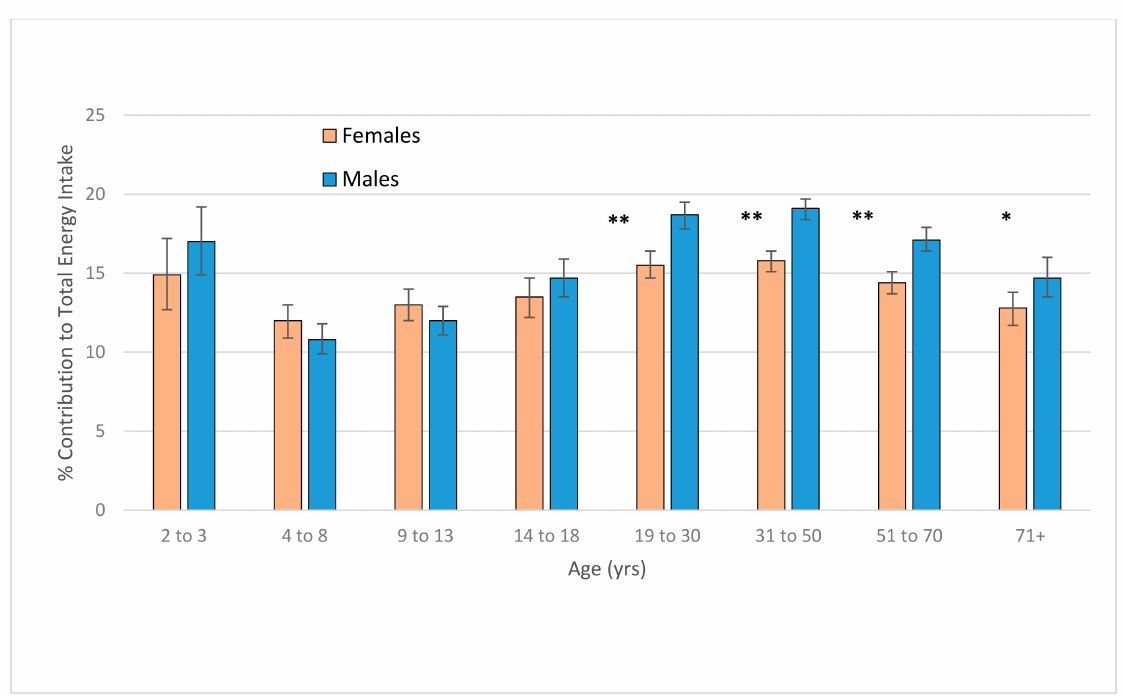
Figure 2. The percentage contribution (mean ± 95% confidence interval [CI]) of total beverage intake to total dietary energy intake for Australians by age group and sex. * Di ff erence between males and females statistically significant at p = 0.01; ** Di ff erence between males and females statistically significant at p <